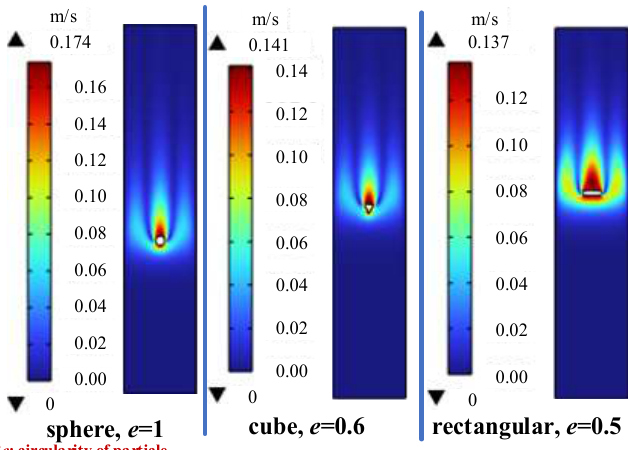
cube, e =0.6sphere, e =1 rectangular, e =0.5 * e : circularity of particle Figure 12. Velocities of particles with different shapes at t = 0.15 s.